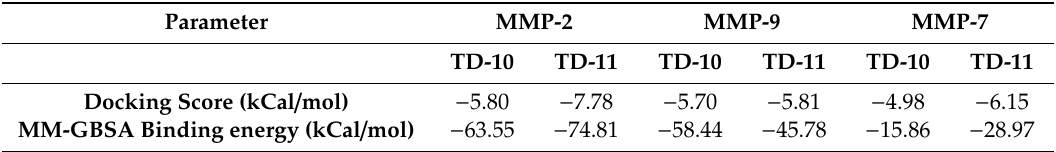
Table 1. Binding energies of TD-10 and TD-11 with MMP-2, MMP-7 and MMP-9